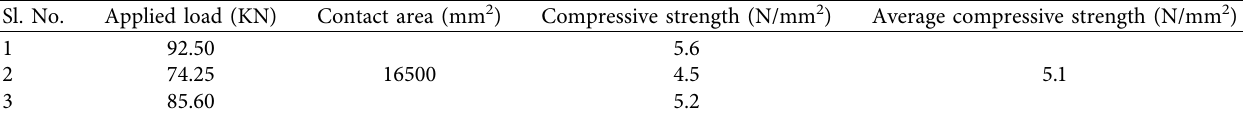
Table 4: Compressive strength test results on locally available conventional